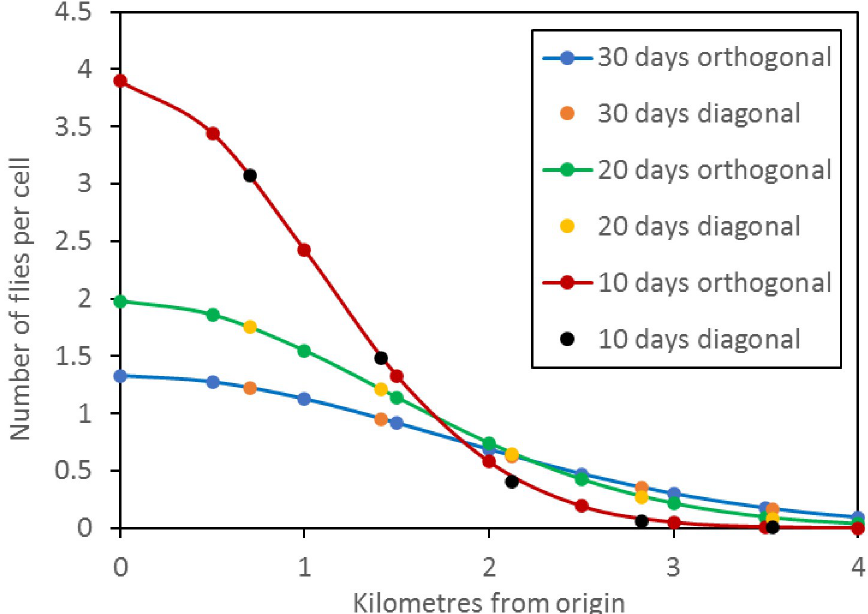
Fig 3. Numbers of flies per cell at different distances in orthogonal and diagonal directions from the cell of origin, after various days of movement. There were 100 flies at the origin before movement began. Fig 1D exemplifies what is meant by orthogonal and diagonal directions of